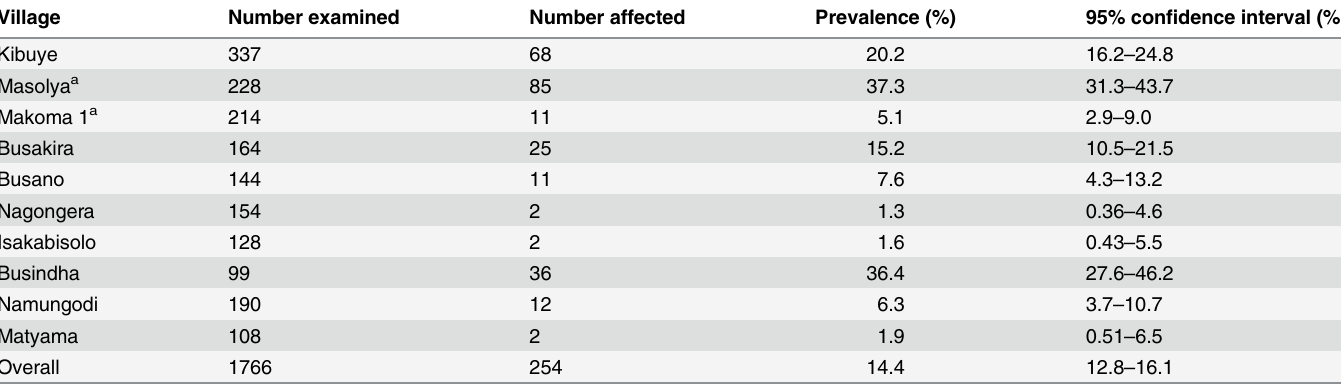
Table 3. Prevalence of human tungiasis in the animal rearing